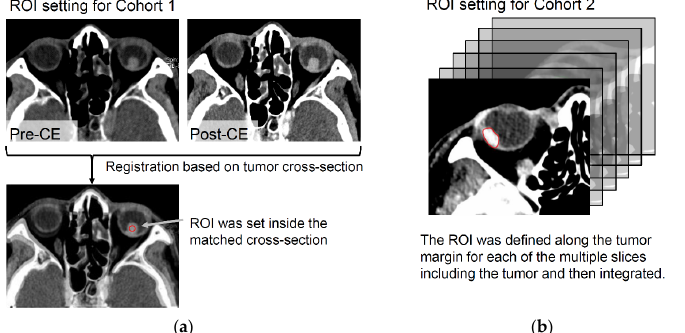
Figure 2. Region of interest (ROI) definition for cohorts 1 and 2. ( a ) In cohort 1, to define a similar ROI for the pre- and post-contrast-enhanced images, the slice with the largest cross-section of the tumor was extracted from the pre- and post-contrast-enhanced series, and the slices were registered according to the tumor cross-sections. Then, the ROI was defined inside the matched tumor cross-section. ( b ) In cohort 2, ROIs were defined along the tumor margins for each slice including the tumor (the top and bottom slices were excluded), and they were integrated to form a single three-dimensional ROI.